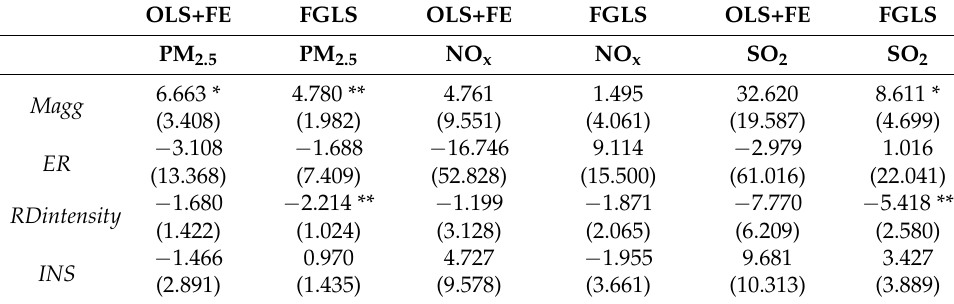
Table A1. Baseline regression results for GDP per capita